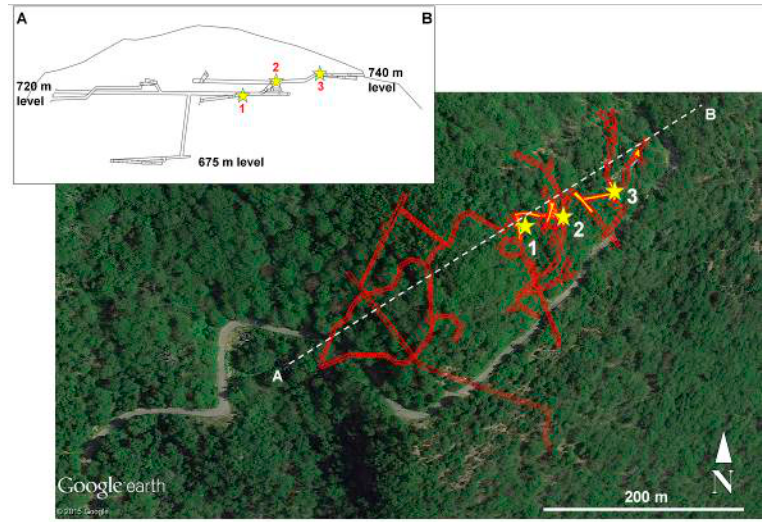
Figure 28. Planimetry of the Fornovolasco mine, showing the occurrence of the three sulfate piles in the old tunnels. Red lines represent the mining works, whereas pyrite ore bodies are shown as the yellow filling in the tunnels. Stars indicate the location of the sulfate piles. The A–B line gives the direction of the vertical section of the mining complex.